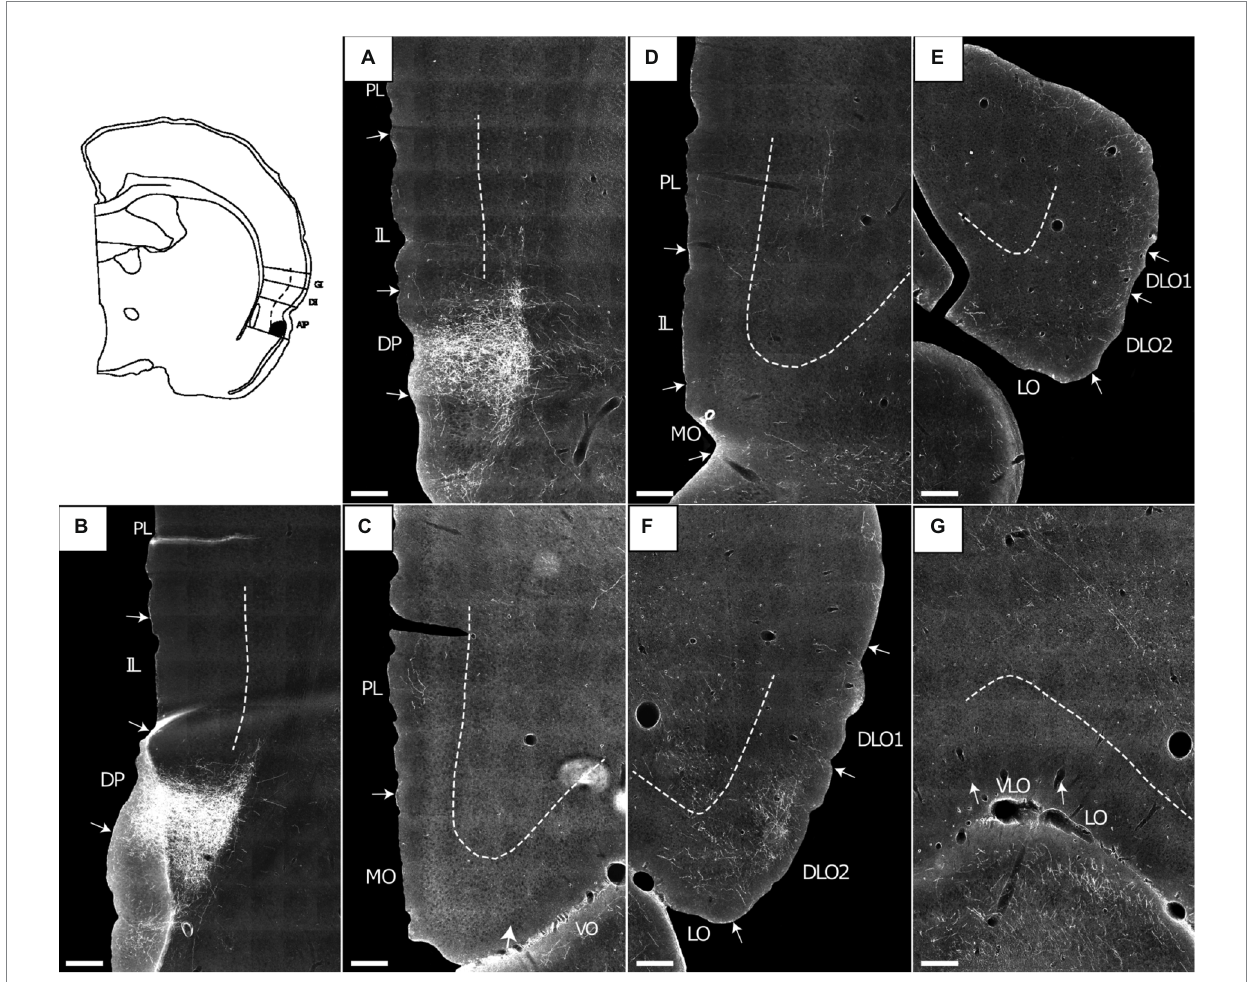
FIGURE 9 Images showing the fiber projections from a BDA injection restricted to the superficial layers of the agranular parietal insular cortex (case 14704B). A schematic depicting the injection site is shown in the upper left corner. (A,B) A very dense and restricted fiber plexus is present in the dorsal peduncular cortex (DP), here shown in two nearby sections. The anterograde labeled fibers extend only very sparsely into the infralimbic cortex (IL). (C,D) Only occasional scattered fiber labeling is present at more rostral portions of the prelimbic (PL) and infralimbic (IL) cortices, as well as the medial orbital field. (E,F) Fibers innervate superficial layers of the dorsolateral orbital field (DLO), particular DLO2, while substantially sparser labeling is present in the lateral orbital field (LO). (G) The ventral (VO) and ventrolateral (VLO) orbital fields are virtually devoid of fiber label. Dashed lines indicate the border between layers 3 and 5. Scale bars equal 250 μ